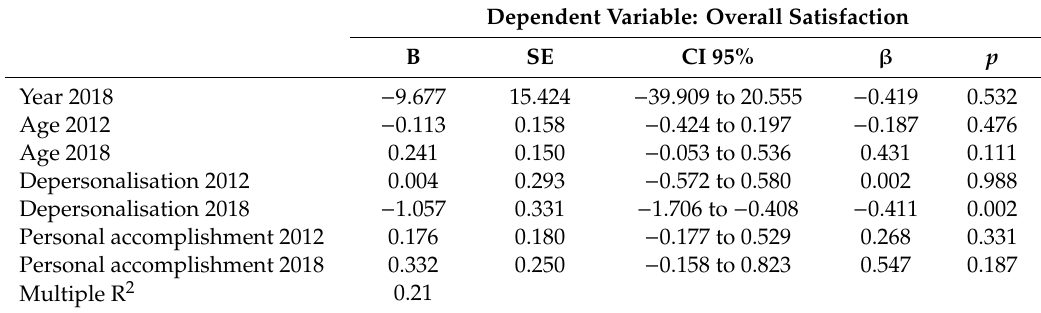
Table 6. Regression models for overall satisfaction in 2012 and